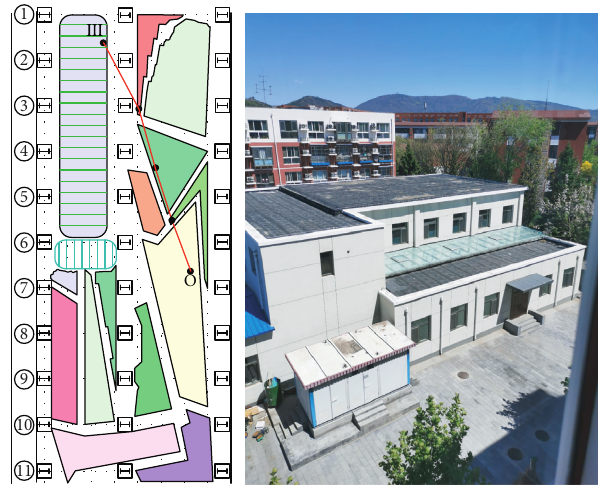
Figure 6: Planning display of civil engineering project from the perspective of